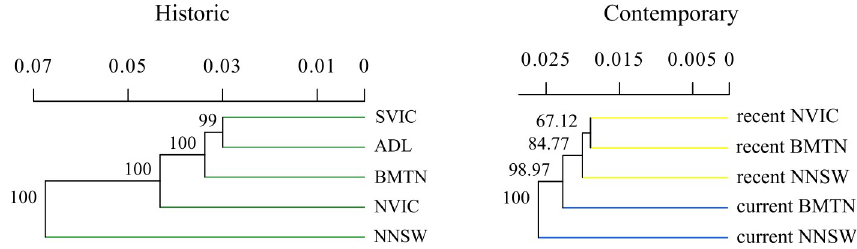
Fig 3. Bootstrapped dendrogram of historic and contemporary samples by a-priori regent honeyeater populations, based on Prevosti’s genetic distance. Note divergence scales differ between trees.